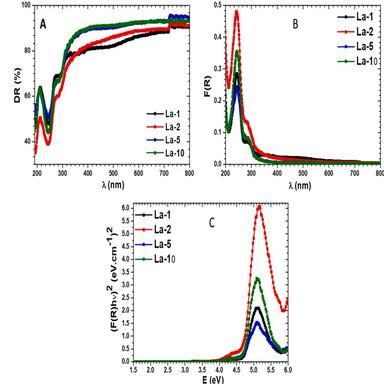
A- The diffuse reflectance spectra of La-TUD-1 samples. B- Kubelka–Munk F(R) function was used to determine the optical band gap of different concentrations of La-TUD-1 samples, and C- Plots of 2 vs optical band gap Eg for La-TUD-1 samples.